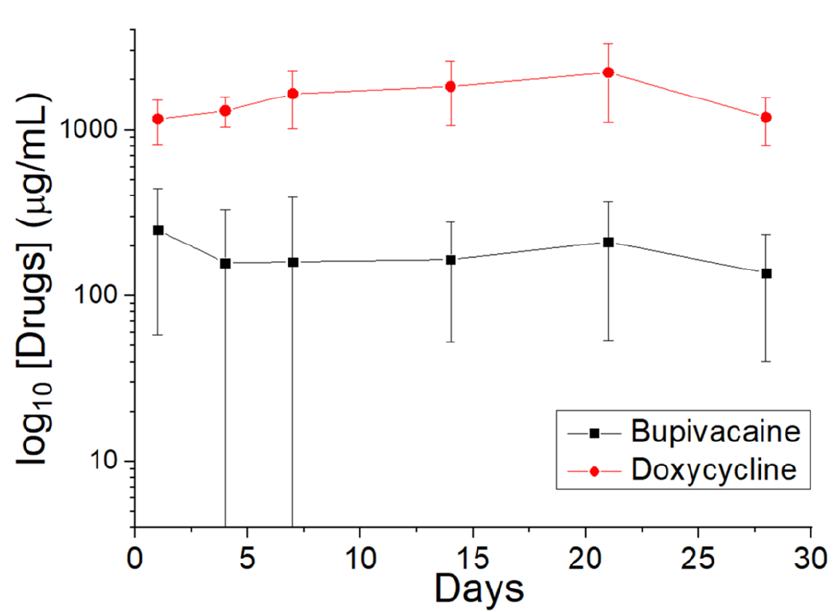
Figure 6. In vivo elution of doxycycline and bupivacaine from DCB – PLGA-composite nanofibers.